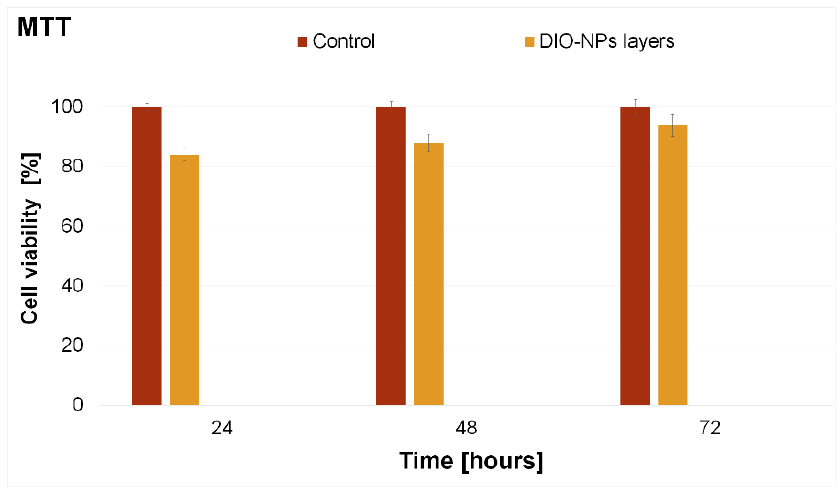
Figure 9. MTT assay of the viability of HepG2 incubated with DIO-NPs layers for 24, 48, and 72 h. The results are presented as means ± standard error. The data were statistically analyzed using paired and two-sample t -tests for means, with p ≤ 0.05 accepted as statistically significant.